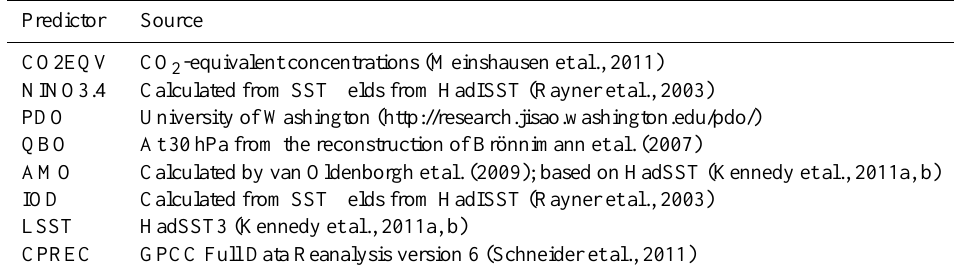
Table 1. Description of predictor variables and their sources.